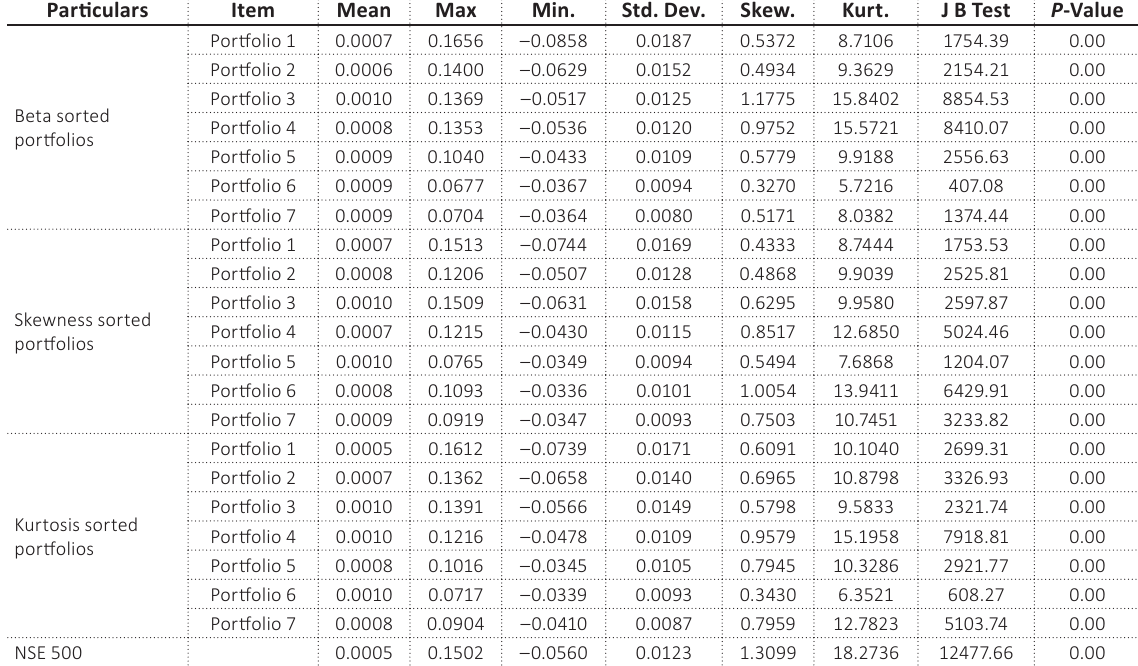
Table 1. Summary statistics of portfolio return